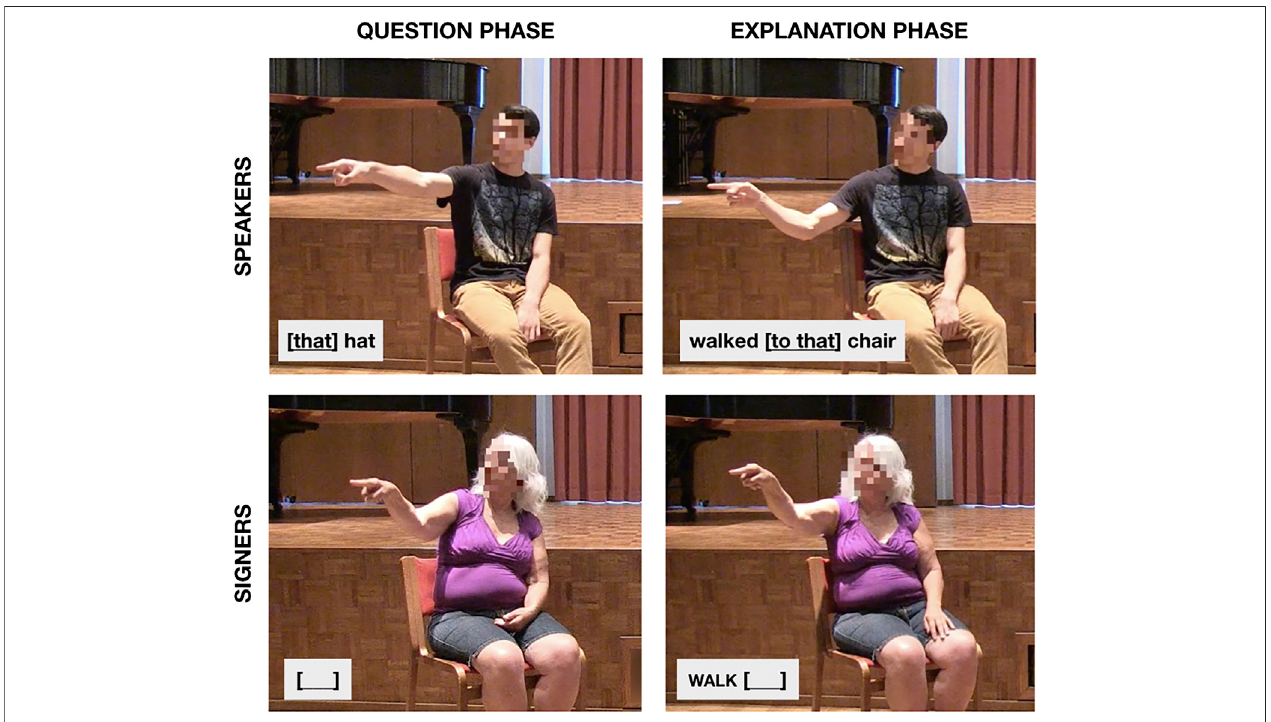
FIGURE 2 | Examples of points produced by a speaker (top row) and signer (bottom row) . Points in the left column were produced in response to a “ which ” / “ where ” question; points in the right column were produced in response to a prompt to explain everything that happened in the scenario.